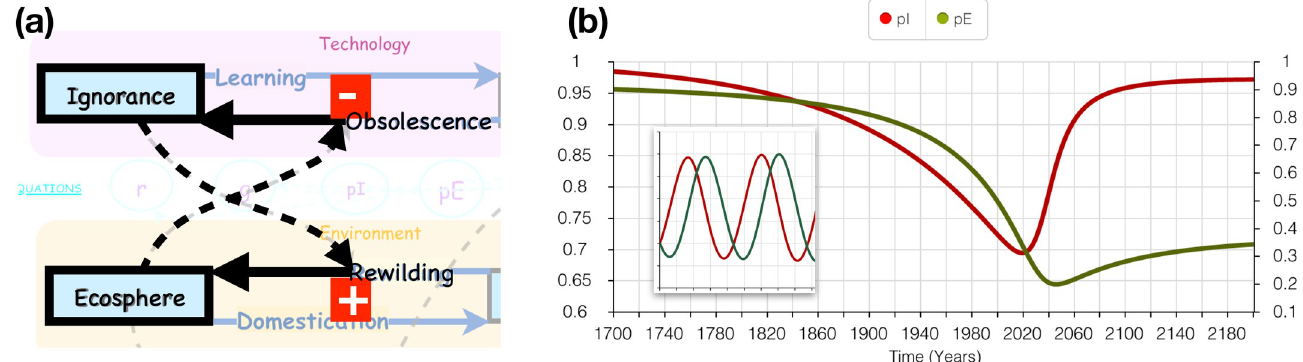
Fig 2. Feedback. (a) Ignorance feeds back in a positive way to rewilding . Rewilding increases ecosphere . Ecosphere feeds back negatively to obsolescence . Obsolescence increases ignorance . (b) Exponential decrease of both ecosphere (pE) by domestication and ignorance (pI) by learning, results in a switch, first in ignorance then in ecosphere . Inset: undamped Lotke-Volterra